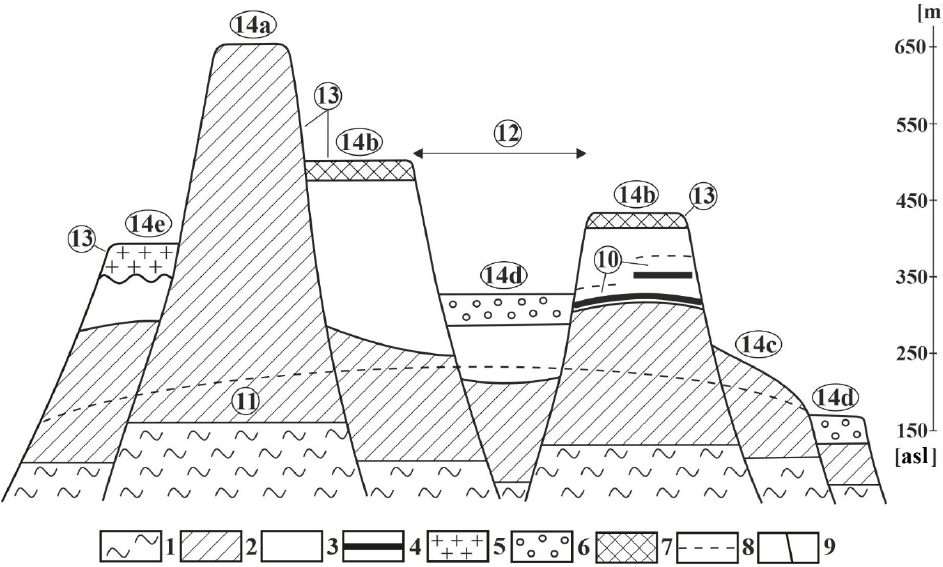
Figure 4. Horst types of the mountains [26]. 1. non-karstic rock, 2. Triassic carbonates, 3. Jurassic, Cretaceous and Eocene limestones, 4. impermeable intercalation, clay, marly limestone, silica, etc.,